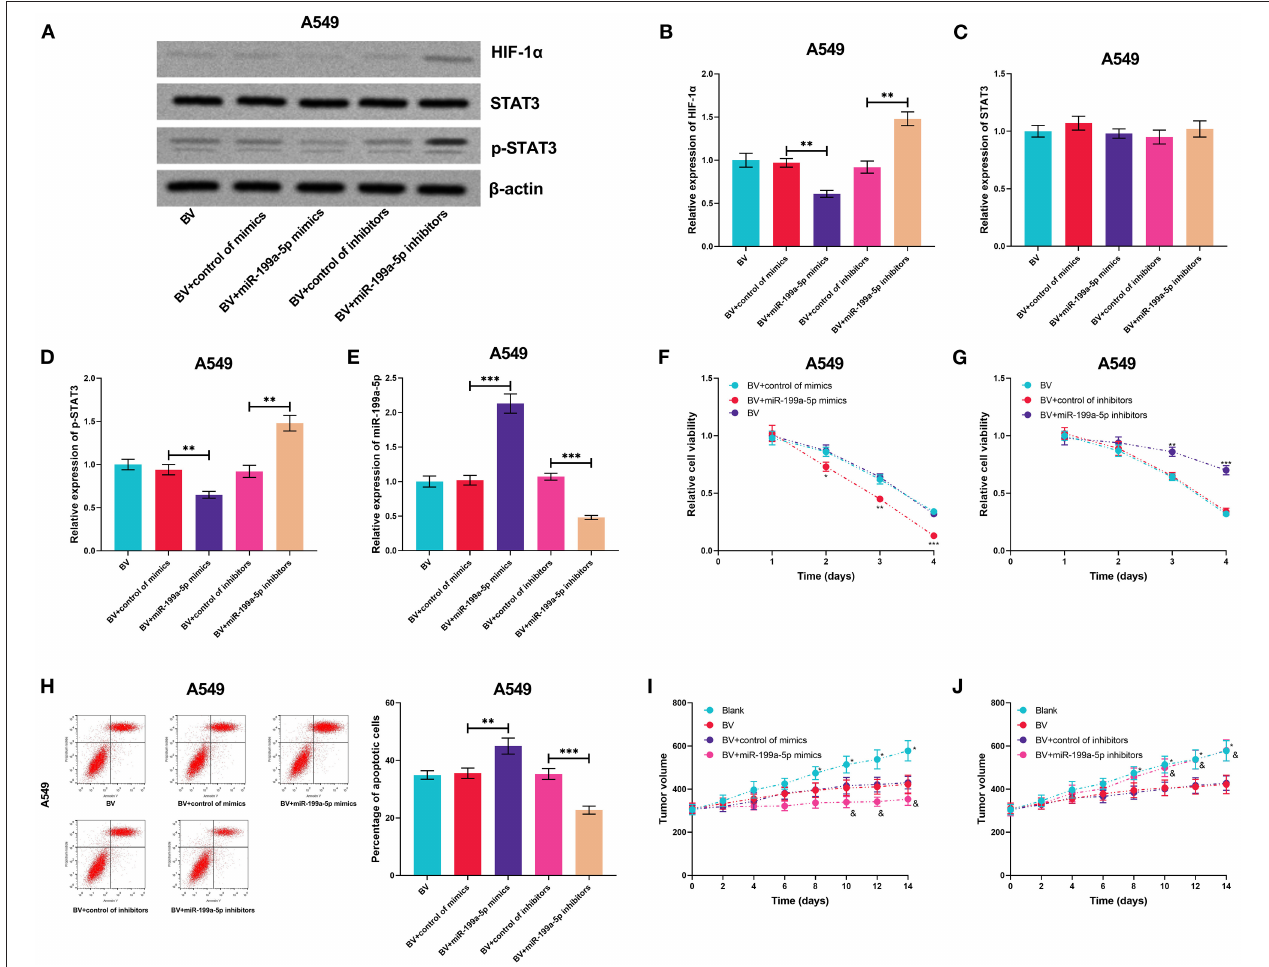
FIGURE 8 | MiR-199a-5p enhanced the effects of bevacizumab on A549 cells. After A549 cells were transfected with miR-199a-5p mimics, or miR-199a-5p inhibitors, the cells were treated with bevacizumab (BV). (A–D) Western blotting was used to detect the expressions of HIF-1 α , STAT3, and p-STAT3 in A549 cells. (E) qRT-PCR was used to detect miR-199a-5p expression in A549 cells after the transfection and BV treatment. (F,G) Proliferation of A549 cells was examined by the CCK-8 assay. (H) Apoptosis of A549 cells was measured using flow cytometry. (I,J) After A549 cells were transfected, the cells were planted into the mice, and then the mice were treated with BV. The changes of tumor volume with time in each group were recorded. All of the experiments were performed in triplicate. * p < 0.05, ** p < 0.01, and *** p < 0.001, respectively. In (I,J) , and represents p < 0.05 BV + control of mimics/inhibitors group vs. BV + miR-199a-5p mimics/inhibitors